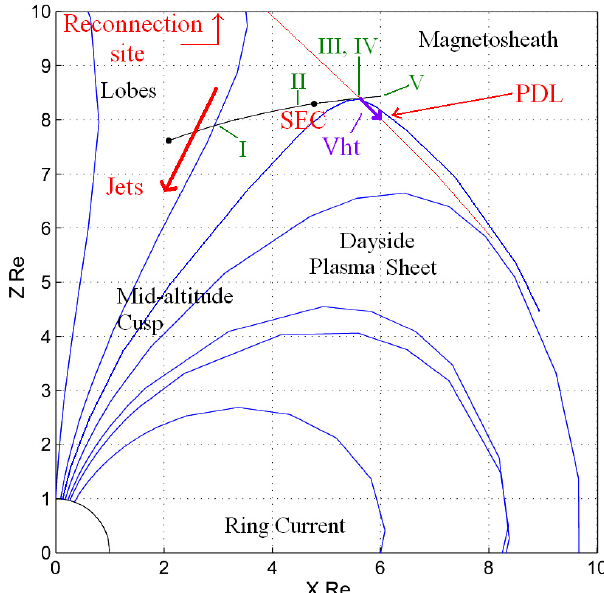
Fig. 8. Schematic of the possible large-scale topology of the ex- terior cusp and surrounding regions as inferred from the present analysis, in the context of lobe reconnection. High-speed down- ward flows are first observed at the poleward boundary with the lobes. The hot, isotropic ions are present first at lower latitudes, and later in the stagnant exterior cusp (SEC) until the spacecraft reach the external boundary. A sub-Alfv´enic plasma depletion layer (PDL) is present in the magnetosheath outside the external bound- ary. The deH-T velocity of the boundary is oriented downward and sunward. The orbit of the Cluster spacecraft is shown for context (case of 16/03/2002), together with the rough locations where each displayed distribution function is observed. I: counter-streaming ion populations (after the large flows); II: isotropic SEC population; III and IV: separated cold, incoming, and hot, outgoing populations right at the external boundary; V: flowing magnetosheath (or PDL)